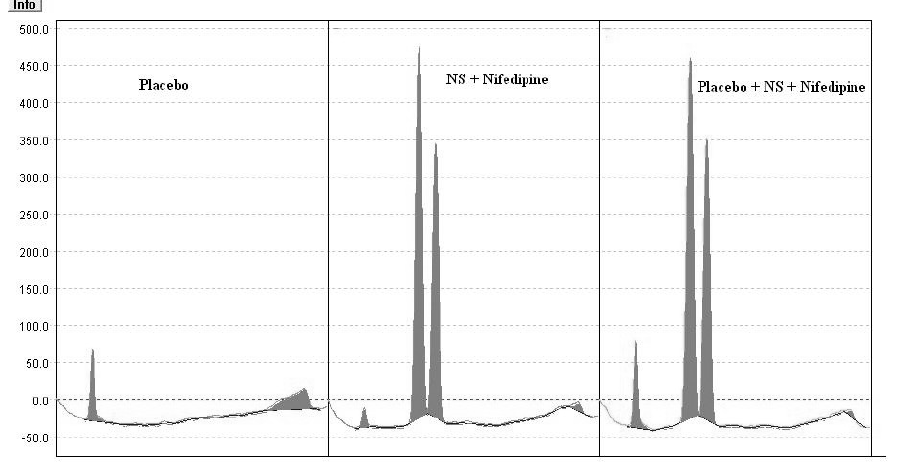
Figure 1. Specificity of analytical method.